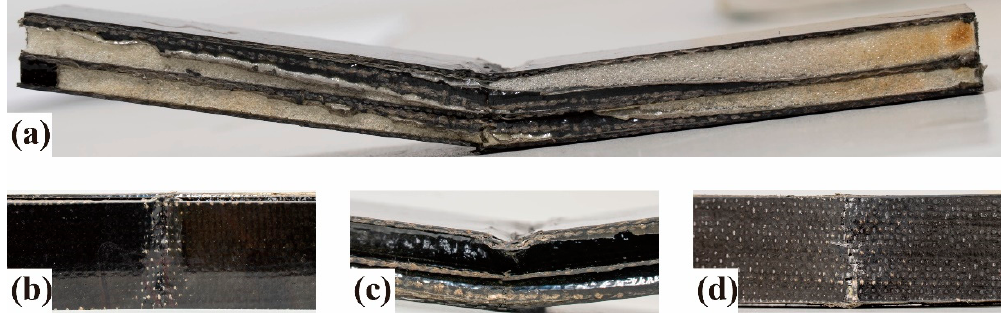
Figure 10. Fracture morphology of the composites. ( a ) Overall view of S2; ( b ) partial top view of S2; ( c ) partial side view of S2; ( d ) partial bottom view of S2.